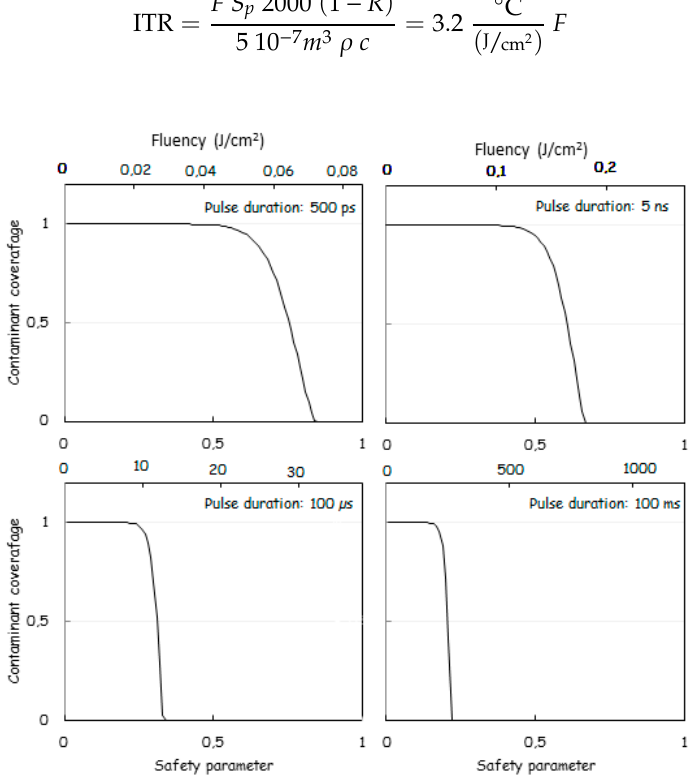
Figure 2. Remaining coverage of the contaminant after one laser shot as a function of the safety parameter ( S a ) and of the laser pulse duration. Table 4. Laser parameters for decontaminating implants. The laser fluency is set to achieve 90% decontamination per laser shot on a spot diameter of 800 µ m. The implant is decontaminated